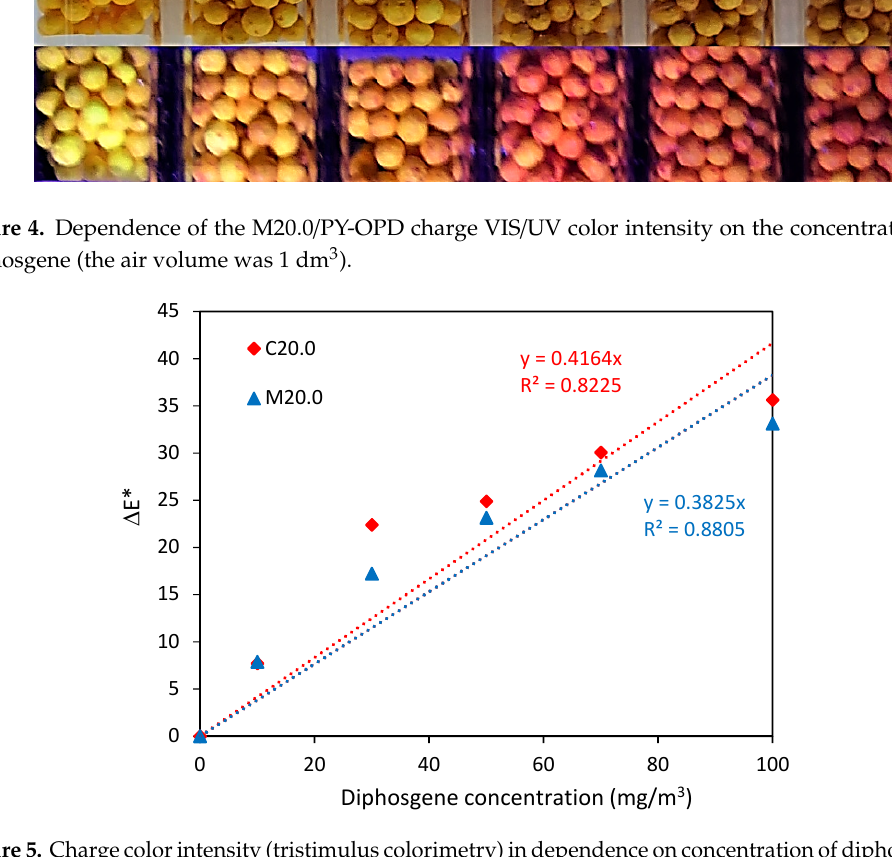
Figure 5. Charge color intensity (tristimulus colorimetry) in dependence on concentration of diphosgene (the air volume was 1 dm 3 ).